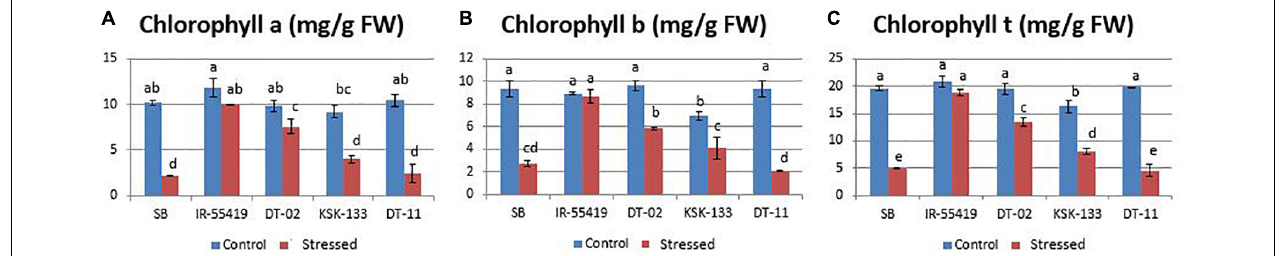
FIGURE 2 | Effect of PEG-induced osmotic stress under hydroponics on chlorophyll a, b, and t of rice genotypes. Genotypes: SB, IR-55419, DT-02, DT-11, and KSK-133. (A) Chlorophyll-a content of control-(non-stressed) and stressed-20% PEG induced osmotically stressed plants. (B) Chlorophyll-b content of control-(non-stressed) and stressed-20% (PEG) induced osmotically stressed plants. (C) Chlorophyll-t (total chlorophyll) of control-(non-stressed) and stressed-20% Polyethylene glycol (PEG) induced osmotic stressed plants in mg/g FW (fresh weight). Ten leaves per plant were homogenized to make a composite sample and three plants per replicate were used. Data represented as mean and means are an average of three biological replicates. According to the least significant difference, means followed by the same letter differ non-significantly at p = 0.01 while different letters show statistical significance of genotypes under control and stressed